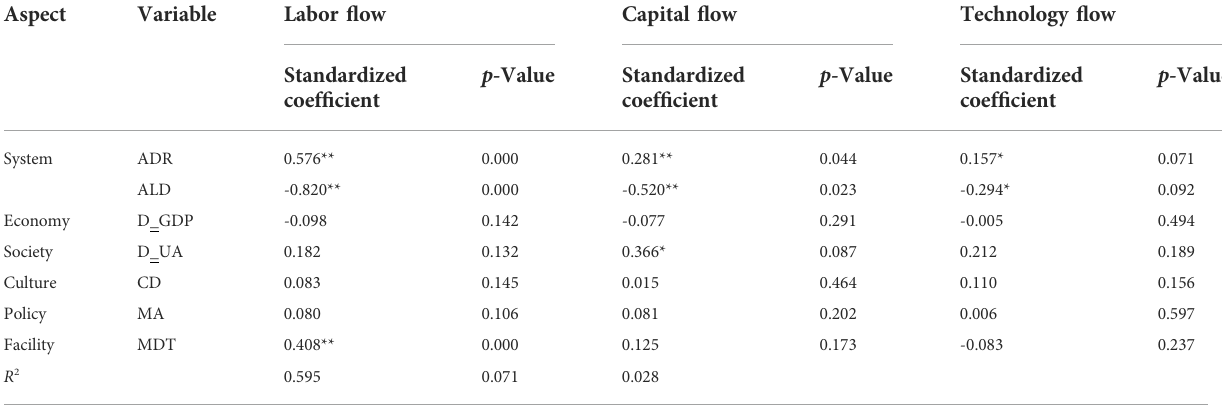
TABLE 4 QAP regression Model on the FFBI of three typical production factors fl